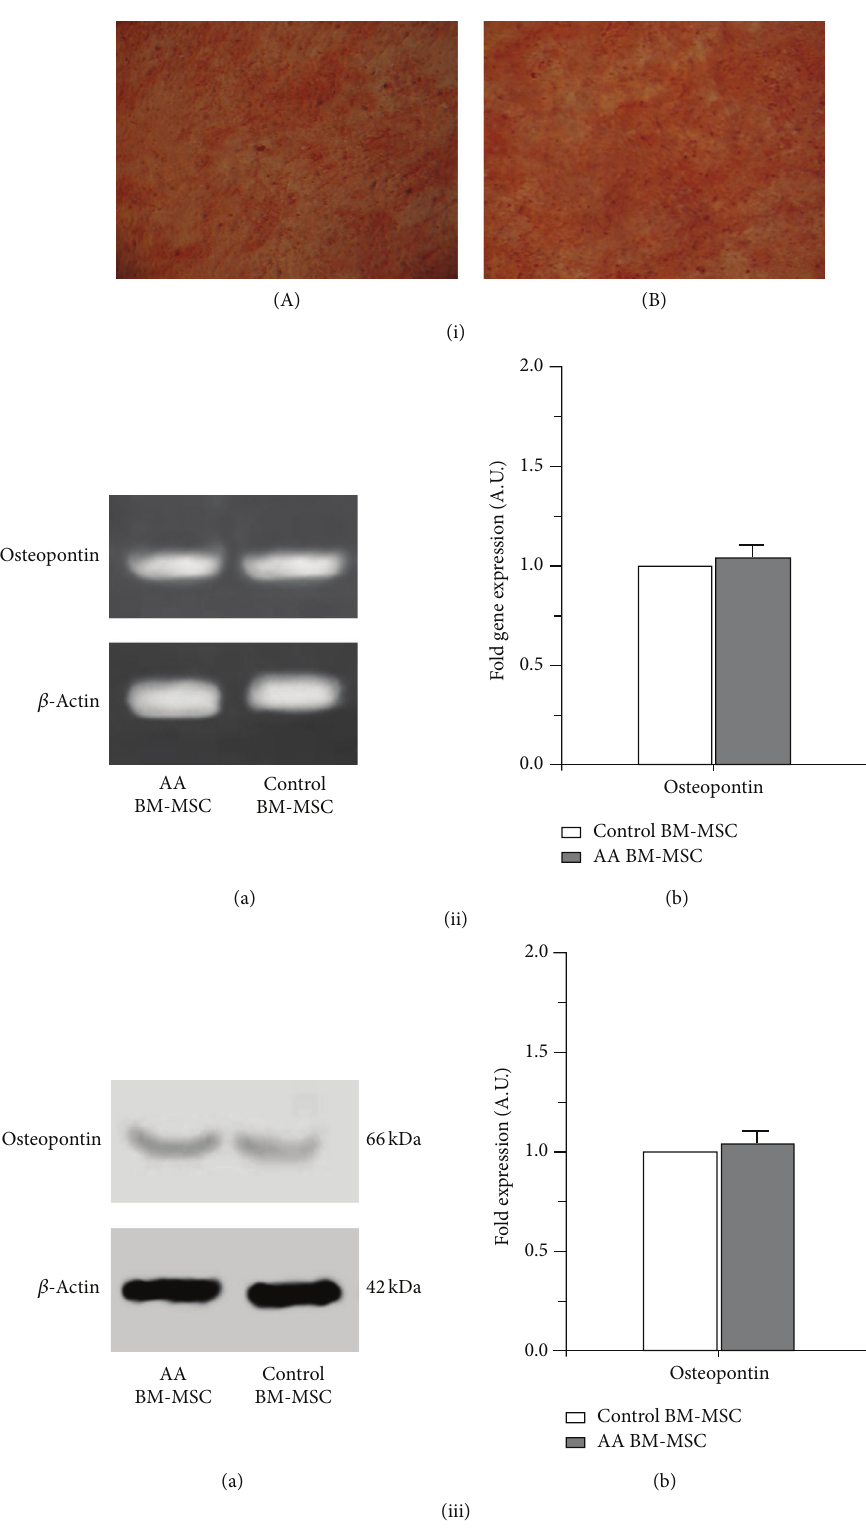
Figure 3: Osteogenic differentiation of BM-MSC of aplastic anemia patients. (i) Alizarin red staining of osteocytes differentiated from BM- MSC of (A) aplastic anemia patients (B) controls (bright field microscope view at 20x). (ii) Gene expression of osteopontin in osteocytes differentiated from BM-MSC of aplastic anemia patients and controls. (a) Representative gel pictures of RT-PCR. (b) Fold gene expression. (iii) Protein expression of osteopontin in osteocytes differentiated from BM-MSC of aplastic anemia patients and controls. (a) Representative Western-blot picture. (b) Fold expression of